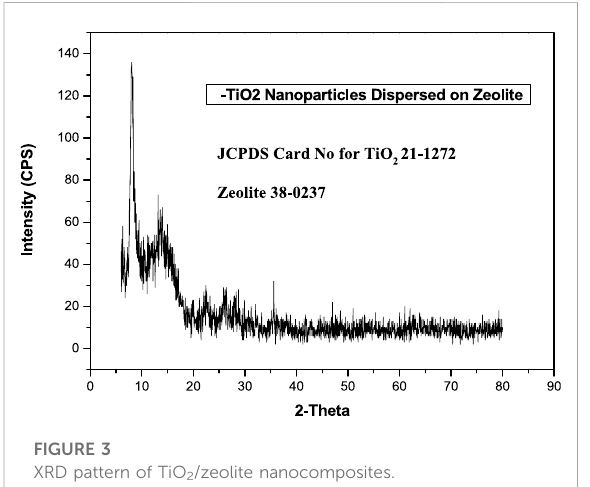
FIGURE 3 XRD pattern of TiO 2 /zeolite nanocomposites.